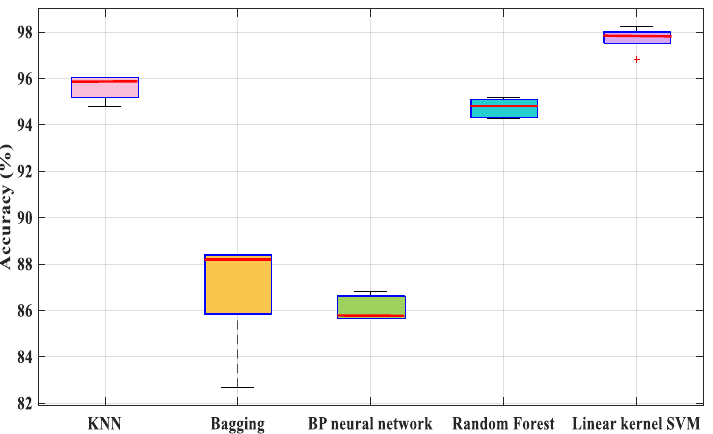
Figure 8. The accuracy boxplot of different classification models on the PTB database.